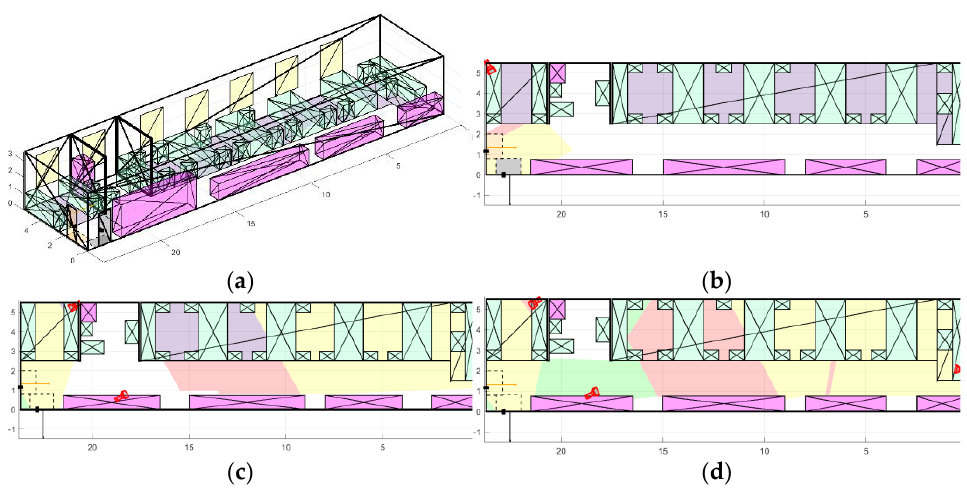
Figure 13. Placement of cameras in room 2: ( a ) room 2 model; ( b ) single camera placement; ( c ) placement of two cameras; and ( d ) placement of three cameras.